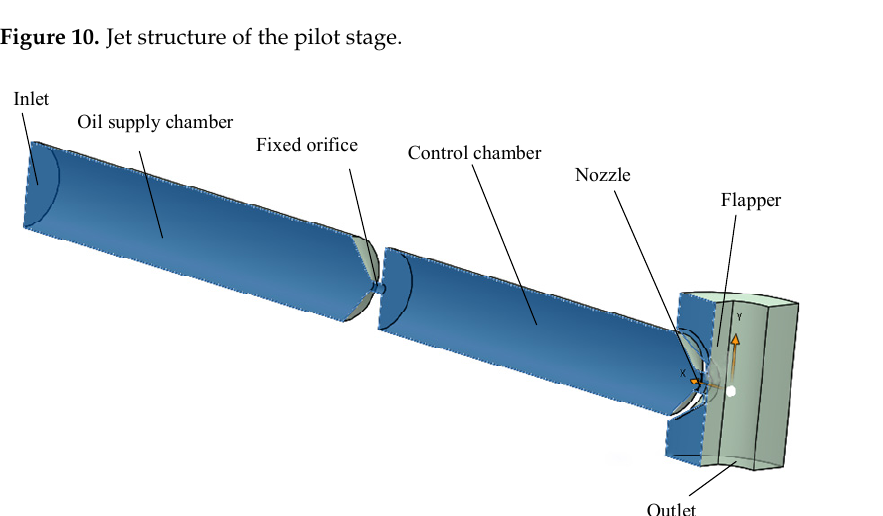
Figure 11. Numerical model for one-quarter section of the jet flow field.